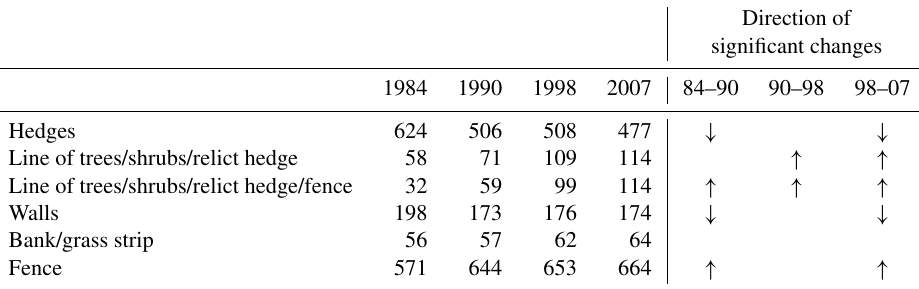
Table 5. The length (thousands of kilometres) and change in length of boundary and linear features in Great Britain, from 1984 to 2007. Arrows denote significant change ( p < 0 . 05) in the direction